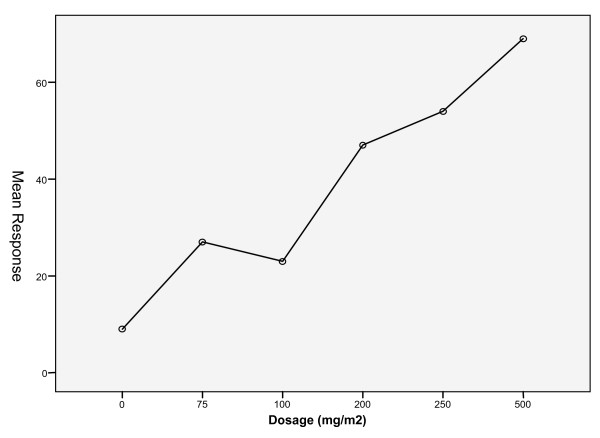
The mean response of mosquito repelled/inhibited from feeding in the tunnel experiment against different dosages (0 mg/m2 (Control), 75 mg/m2, 100 mg/m2, 200 mg/m2, 250 mg/m2, 500 mg/m2) of plant extracts.